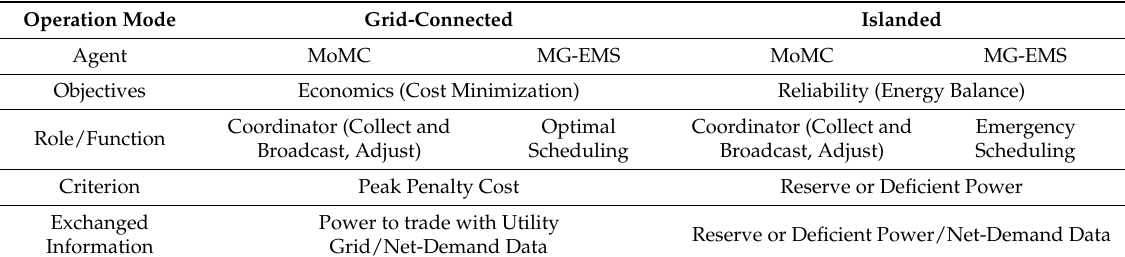
Table 2. Definition of microgrid of microgrids (MoMC) and microgrid energy management system (MG-EMS) functions.